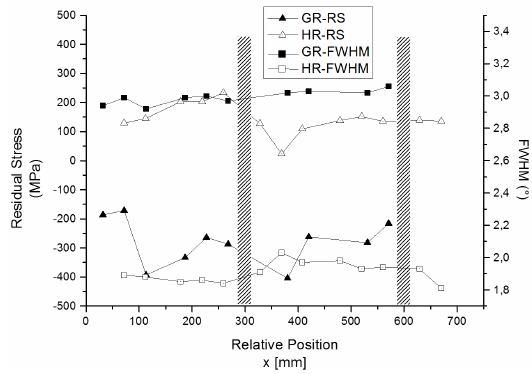
Figure 3. Residual stress and FWHM profiles measured along the longitudinal (“x”) direction for GR and HR